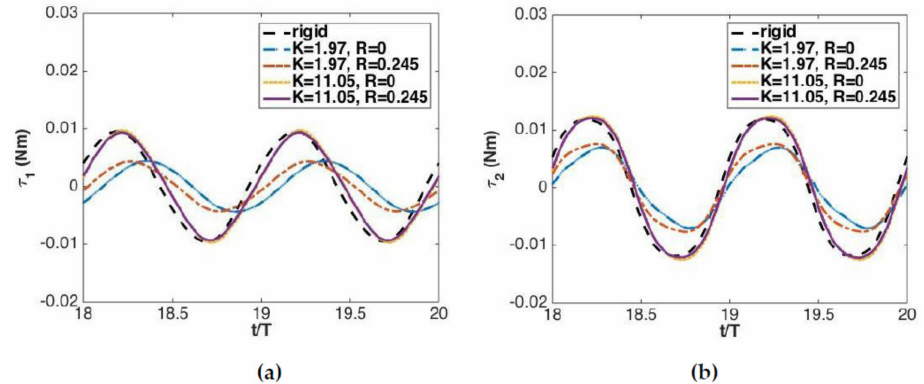
Figure 10. Torque history ( a ) at passive joint ( τ 1 ) and ( b ) at active joint ( τ 2 ).